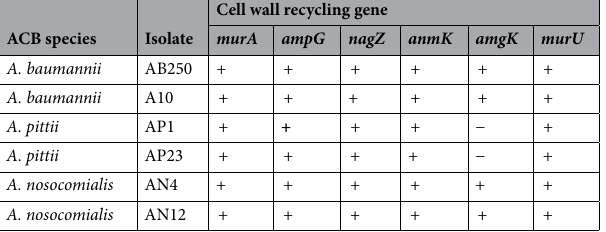
Table 4. The presence of cell wall recycling enzyme genes in six ACB isolates. (+) presence of gene, ( − ) absence of